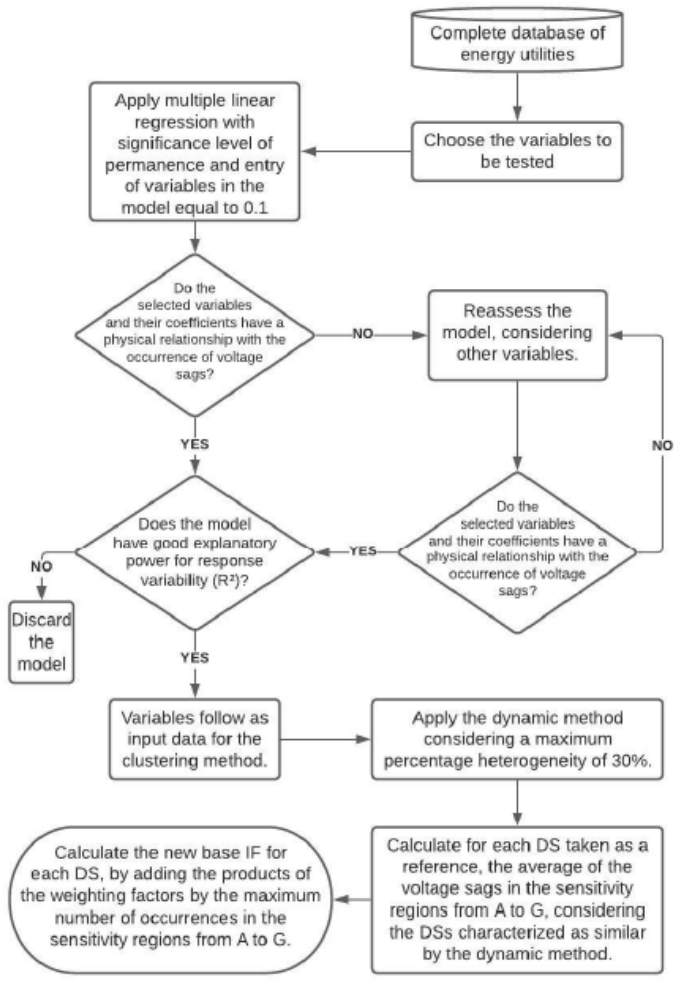
Figure 1. Flowchart of the proposed methodology [14].